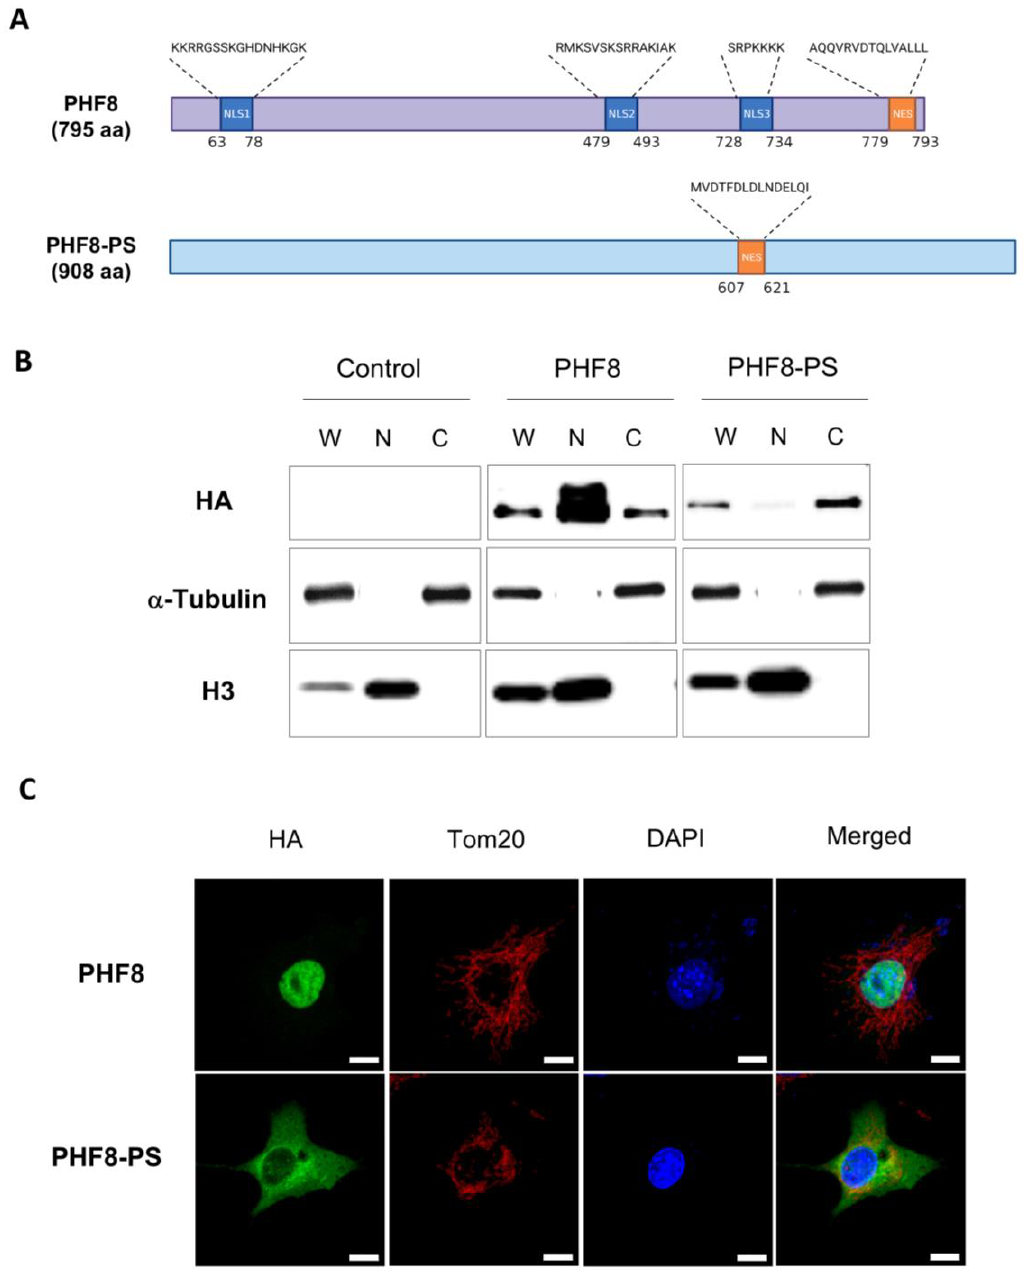
Figure 4. Subcellular localization of PHF8-PS. ( A ) Schematic representation of nuclear localization signals (NLS) and nuclear export signals (NES) in PHF8 and PHF8-PS proteins (image created with Biorender.com). ( B ) Cell fractionation of NIH3T3 cells transiently expressing HA/FLAG-tagged PHF8 and PHF8-PS proteins. Whole cell lysate (W), nuclear (N), and cytoplasmic (C) fractions were analyzed by Western blot as indicated. ( C ) Co-immunostaining images of NIH3T3 cells transiently expressing HA/FLAG-tagged PHF8 and PHF8-PS showing the subcellular localization of these proteins (green) and that of the mitochondrial marker Tom20 (red). Cell nuclei were stained DAPI (blue). Scale bar: 10 µ